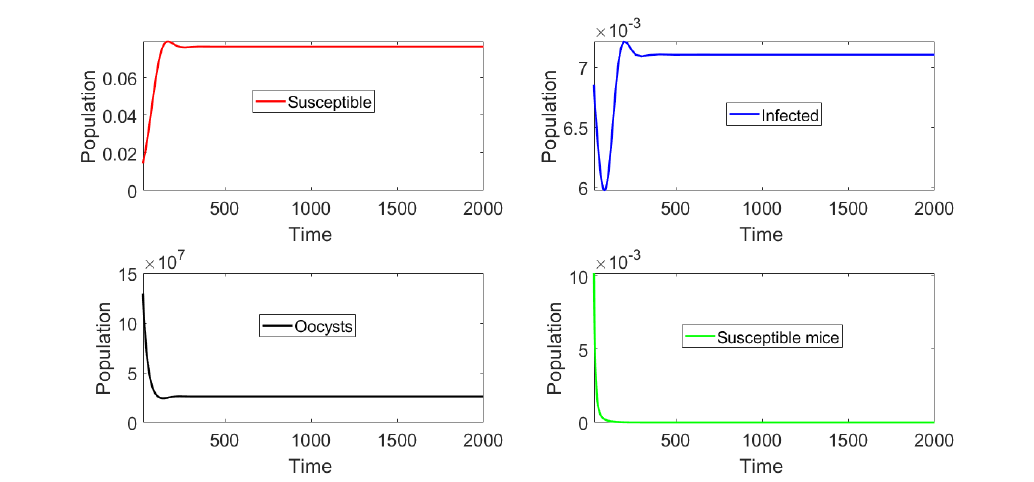
Figure 5. Dynamics of the different classes with no vaccination and R 0 ≈